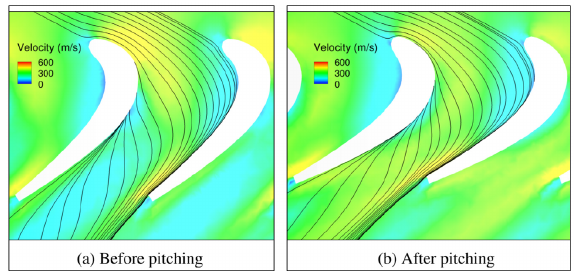
Figure 2. Streamlines through rotor passage indicating reduced flow separation after pitching of the rotor blade cascade